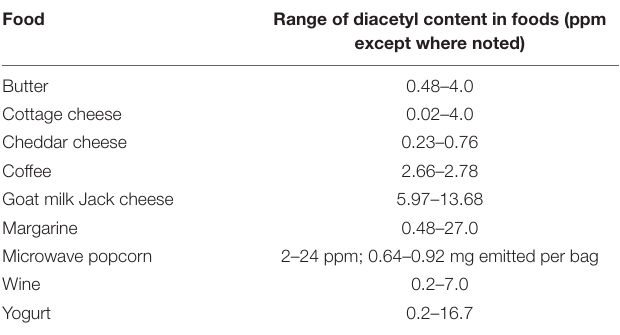
TABLE 3 | The levels of diacetyl measured in selected foods (Clark and Winter, 2015). Food Range of diacetyl content in foods (ppm except where